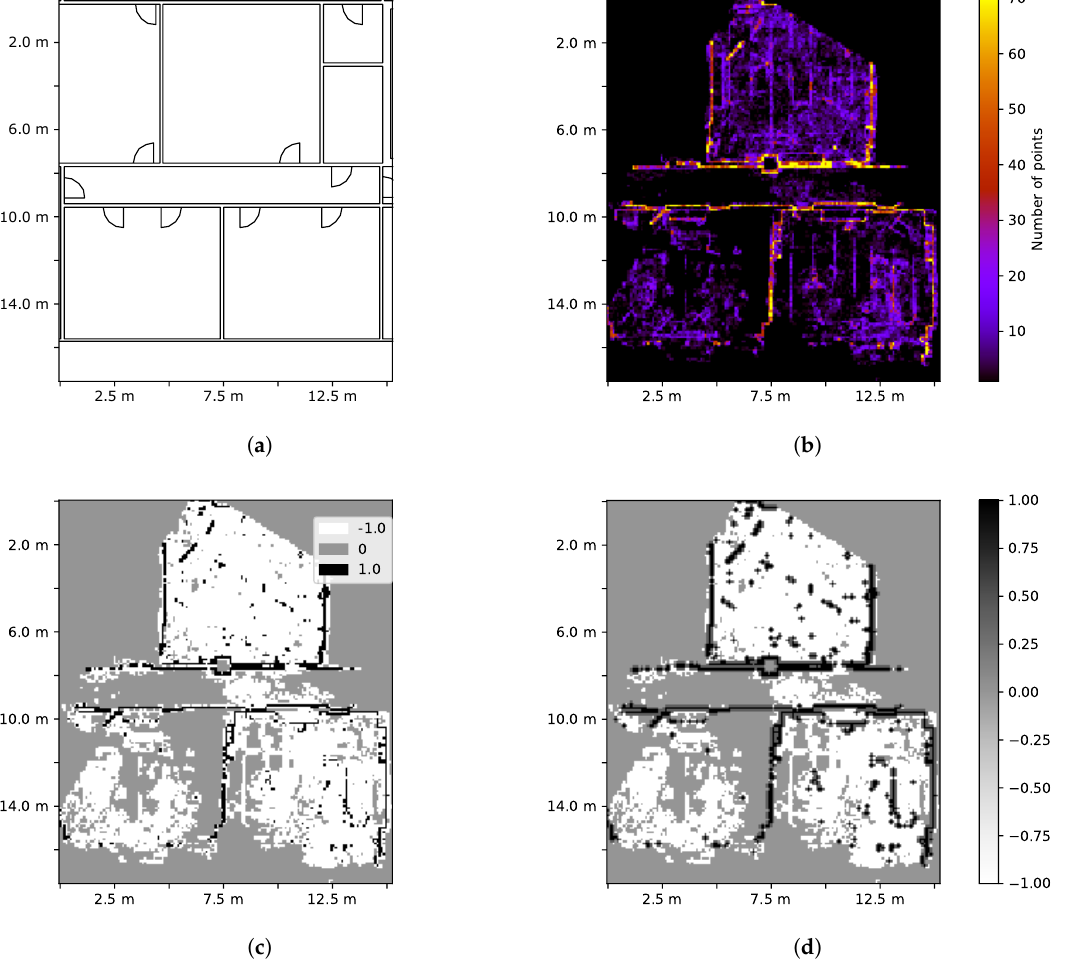
Figure 3. The rasterization process of an axis-aligned point cloud: ( a ) The original layout in the BIM model; ( b ) the axis-aligned floor plan c i , j of a recorded point cloud, where the walls and floors are clearly visible while unobserved locations are in black; ( c ) the floor plan c i , j with applied thresholding, where observed walls have a value of 1, observed floors have a value of − 1, and unobserved parts have a value of 0; and ( d ) the combined floor plan g i , j